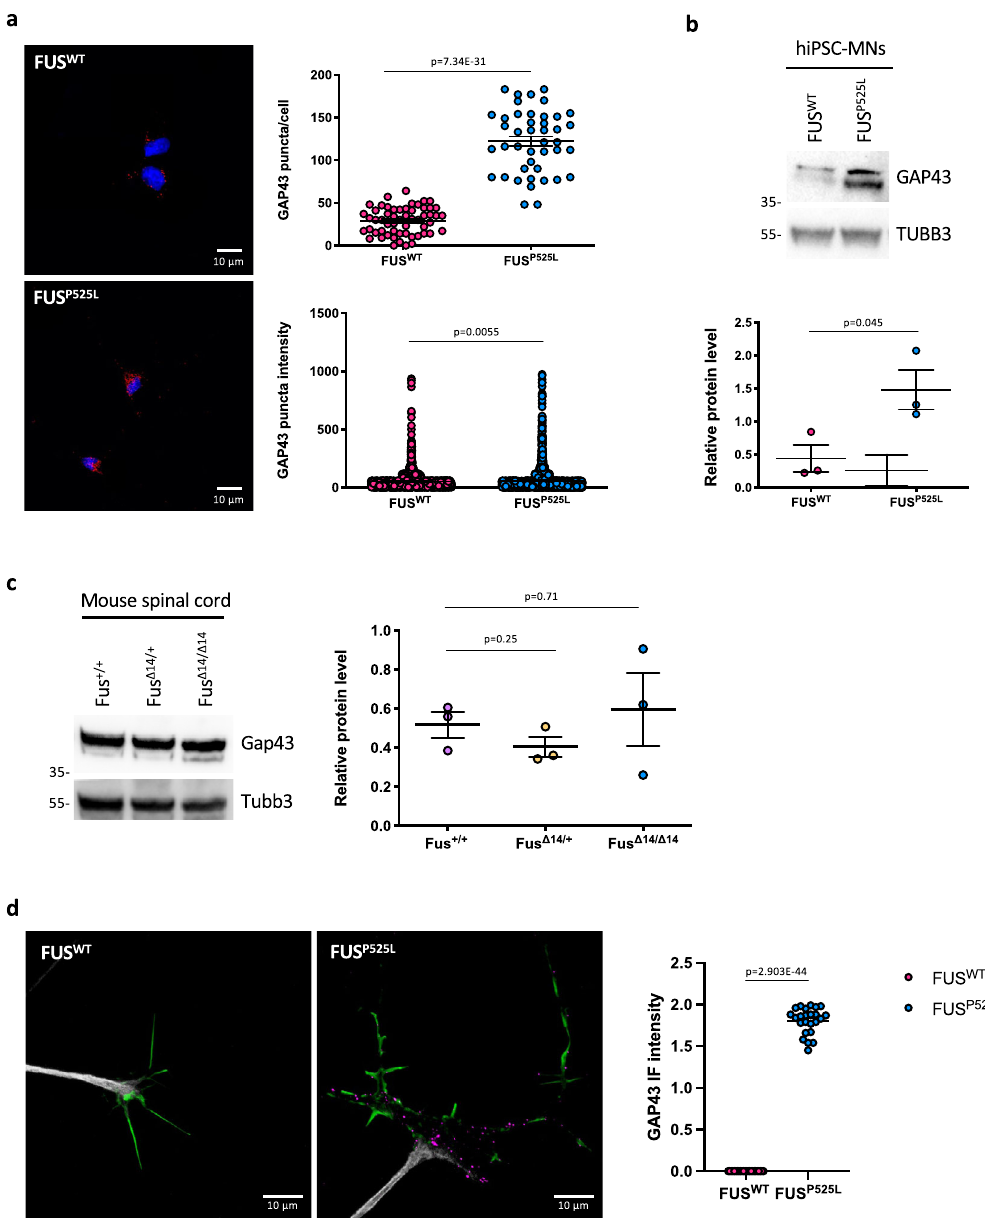
Fig. 7 GAP43 levels are increased in mutant FUS MNs. a GAP43 mRNA analysis by FISH (red) in FUS WT , FUS P525L , and FUS WT overexpressing HuD under the Syn1 promoter (FUS WT + HuD) hiPSC-derived spinal MNs. The graphs show the average count of HuD mRNA puncta per cell from three independent differentiation experiments, error bars indicate the standard error of the mean (Student ’ s t -test; unpaired; two tails). DAPI (blue) was used for nuclear staining. Scale bar: 10 μ m. b GAP43 protein levels analysis by western blot in FUS WT and FUS P525L hiPSC-derived spinal MNs. The molecular weight (kDa) is indicated on the left. The graph shows the average from three independent differentiation experiments and error bars indicate the standard deviation (Student ’ s t -test; paired; two tails). Values in the y -axis represent GAP43/TUBB3 signal intensity. c Gap43 protein level analysis by western blot in mouse primary spinal MNs (P81). The molecular weight (kDa) is indicated on the left. The graphs show the average from three mice and error bars indicate the standard deviation. The differences are not signi fi cant for all pairs (ordinary one-way ANOVA; multiple comparisons). Values in the y -axis represent Gap43/Tubb3 signal intensity. d Immunostaining analysis in FUS WT and FUS P525L hiPSC-derived spinal MNs growth cones. GAP43 signal is magenta; PHALLOIDIN signal (marking growth cones) is green, TYR-TUBULIN (tyrosinated alpha-tubulin; marking axons) is white. Scale bar: 10 μ m. The graph shows the GAP43 signal intensity from three differentiation experiments, error bars indicate the standard error of the mean (Student ’ s t -test; paired; two